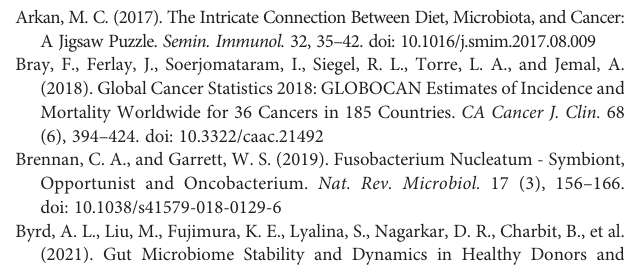
Supplementary Figure 1 | The Shannon-Wiener curve. Supplementary Figure 2 | The comparison of the sobs 、 ace, and chao index level among three groups. (Y: young volunteers; O: old volunteers; C: CRC